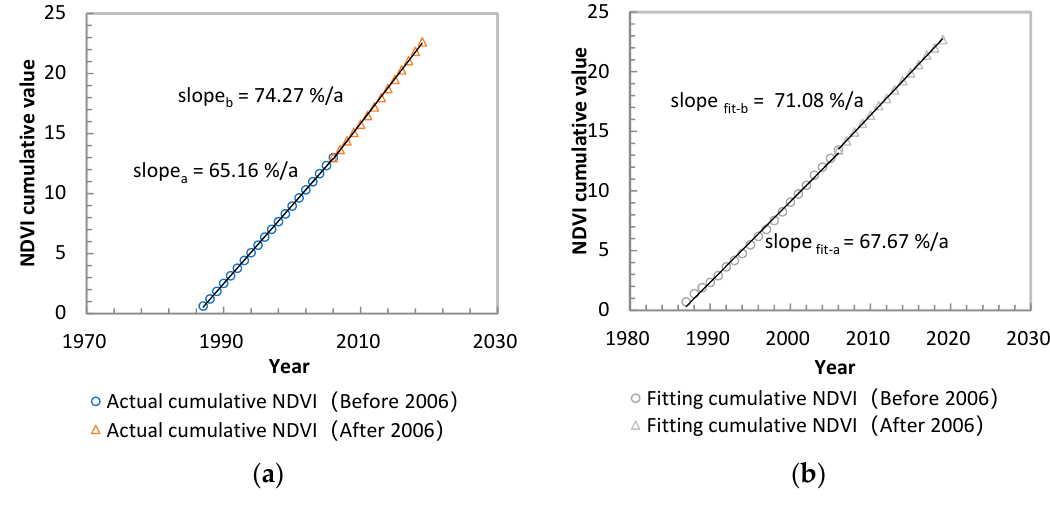
Figure 11. The relationship between the cumulative NDVI and the year. ( a ) Cumulative actual NDVI. ( b ) Cumulative fitting NDVI.